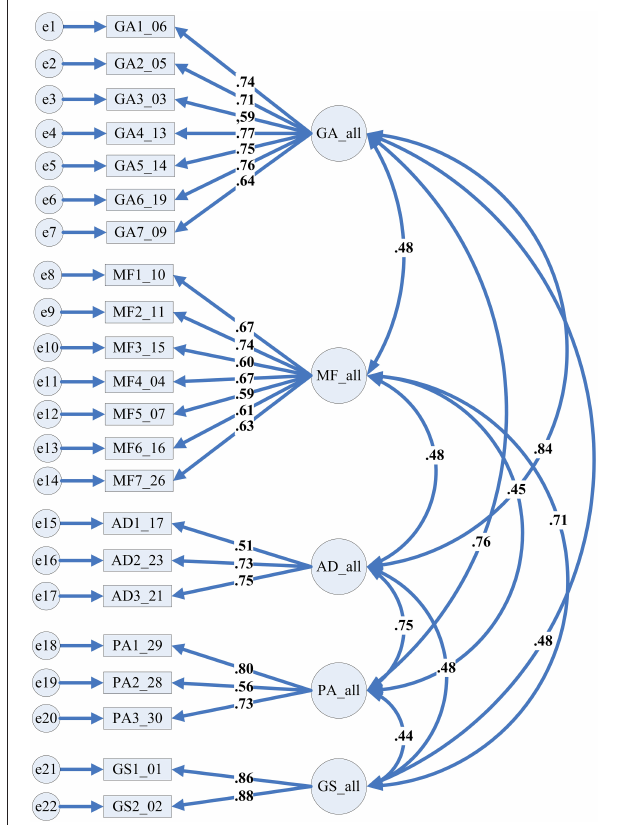
FIGURE 1 | Path model and factor loadings of